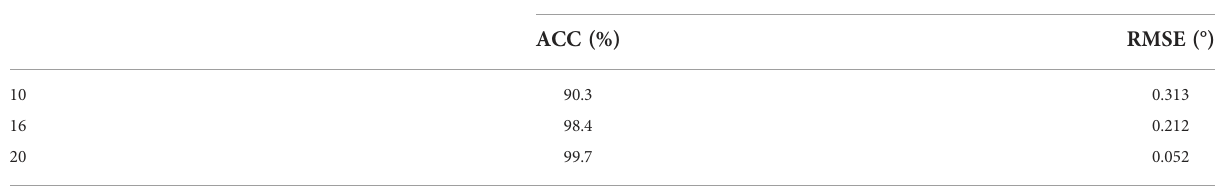
TABLE 4 Performance comparison of different array elements under SNR of -10